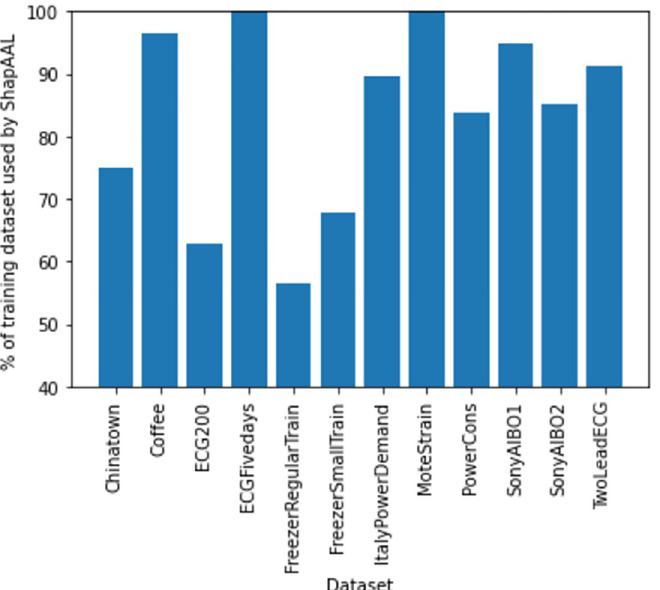
Fig 10. Selection of subset by ShapAAL algorithm for different